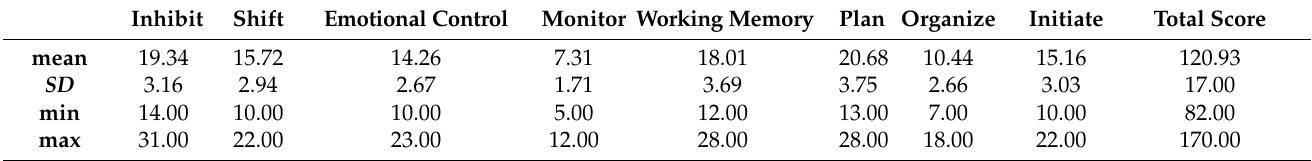
Table 2. Descriptive results of BRIEF-SB